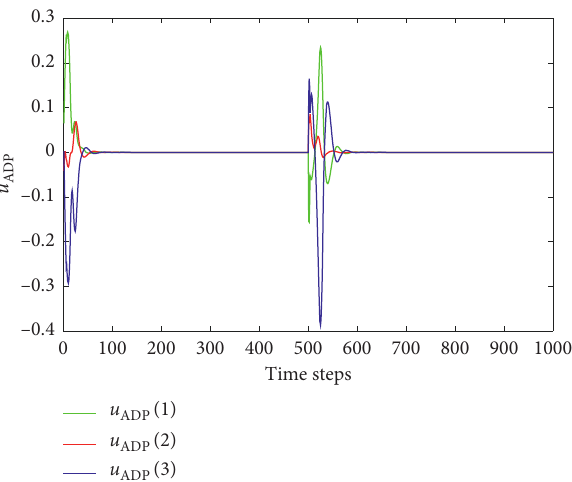
Figure 11: Optimal control signal u